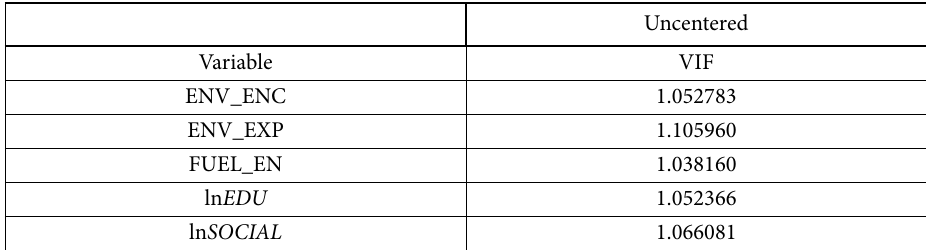
Table 10. VIF estimation (source: author’s own